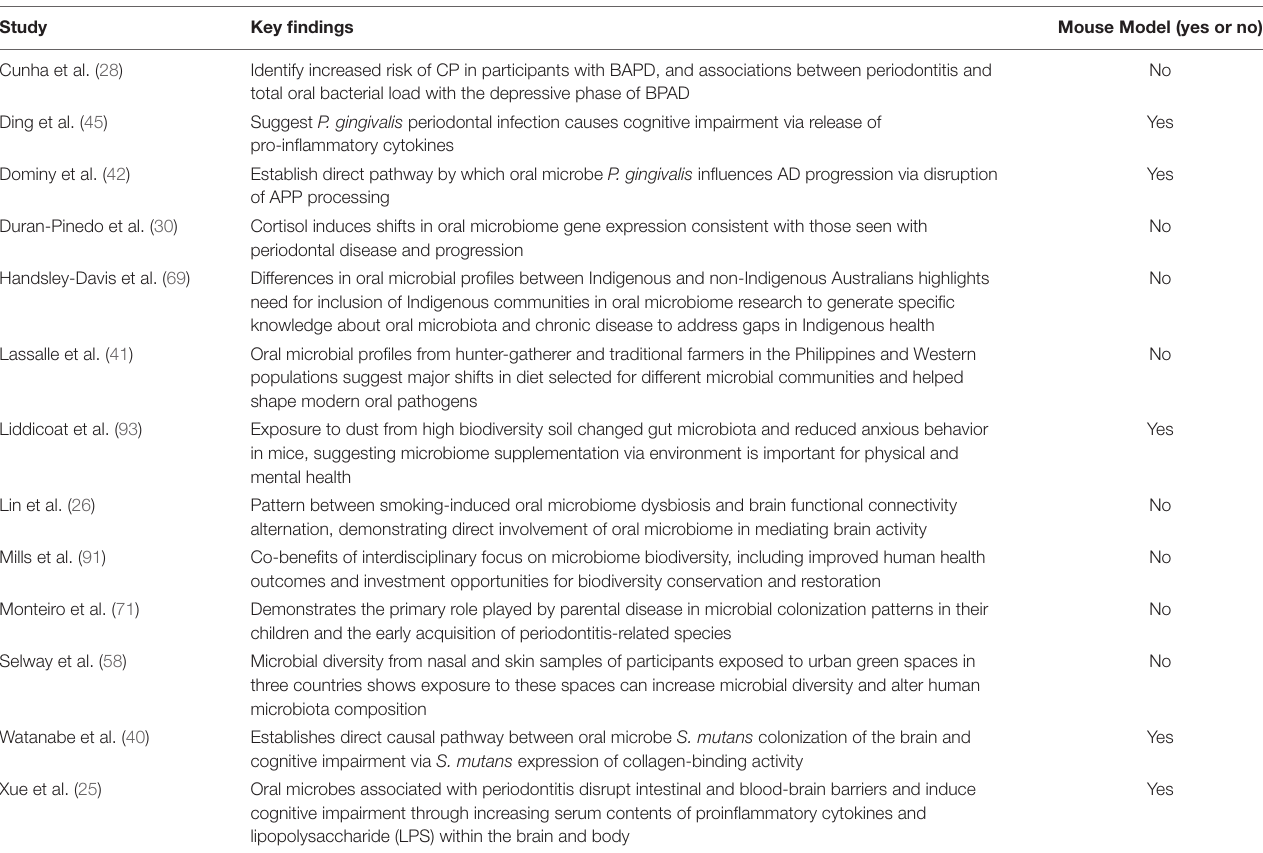
TABLE 1 | Summary of key studies and findings discussed in this review. Study Key findings Mouse Model (yes or